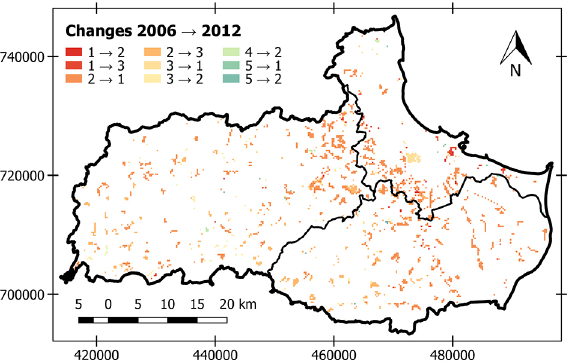
Fig. 6. Change map between land use in 2006 and